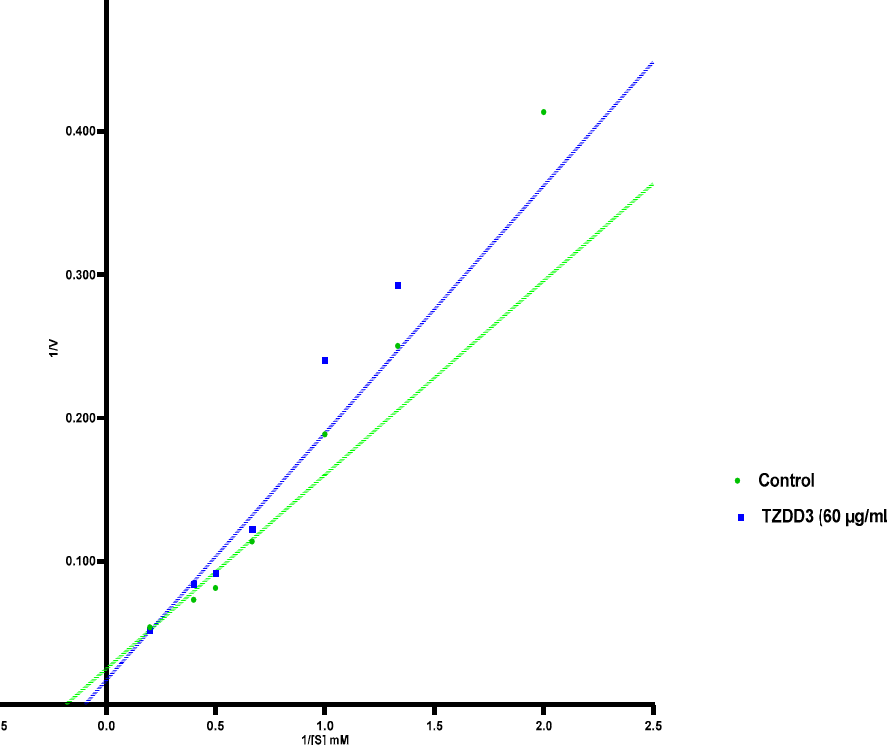
Figure 3. Lineweaver-burk plot of kinetic analysis of α -glucosidase inhibition by TZDD3 at 120 µg/mL.